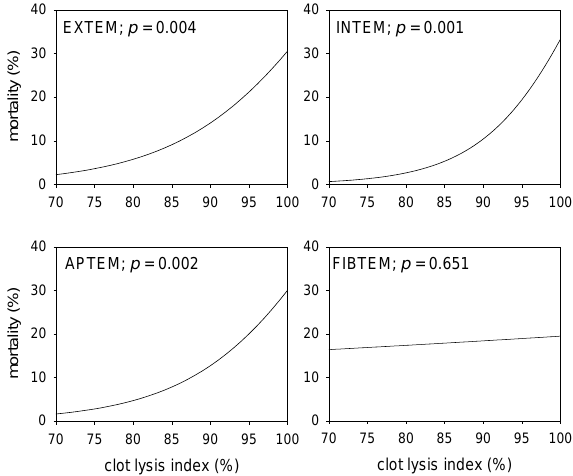
Figure 2. Effect of the clot lysis indices obtained with four different ROTEM™ assays before the start of the liver transplantation procedure on the 30-day mortality. Shown are calculations resulting from univariate binary logistic regression analyses and the corresponding significance levels.